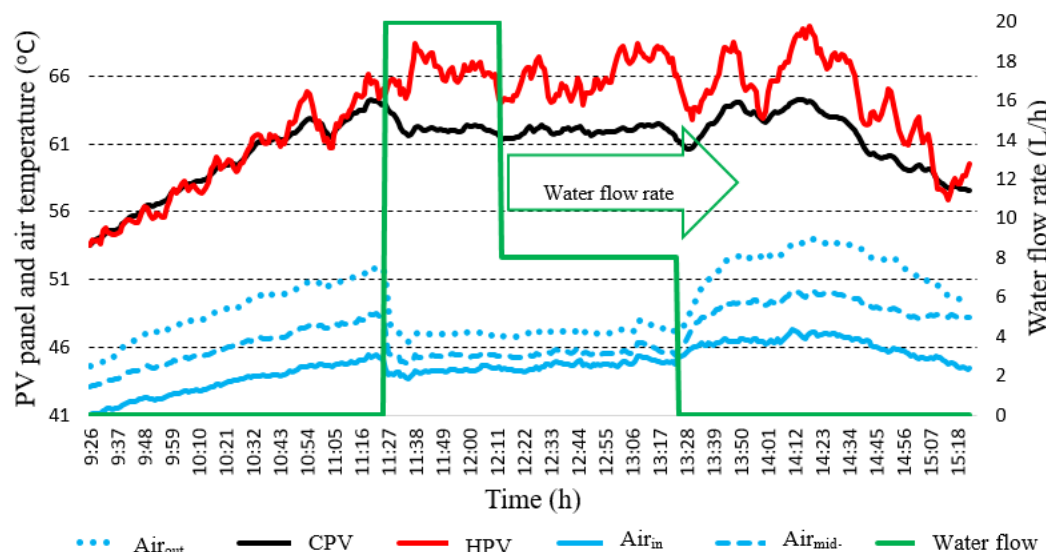
Figure 9. Effect of water flow rate on air and cooled PV temperature, 19 August.